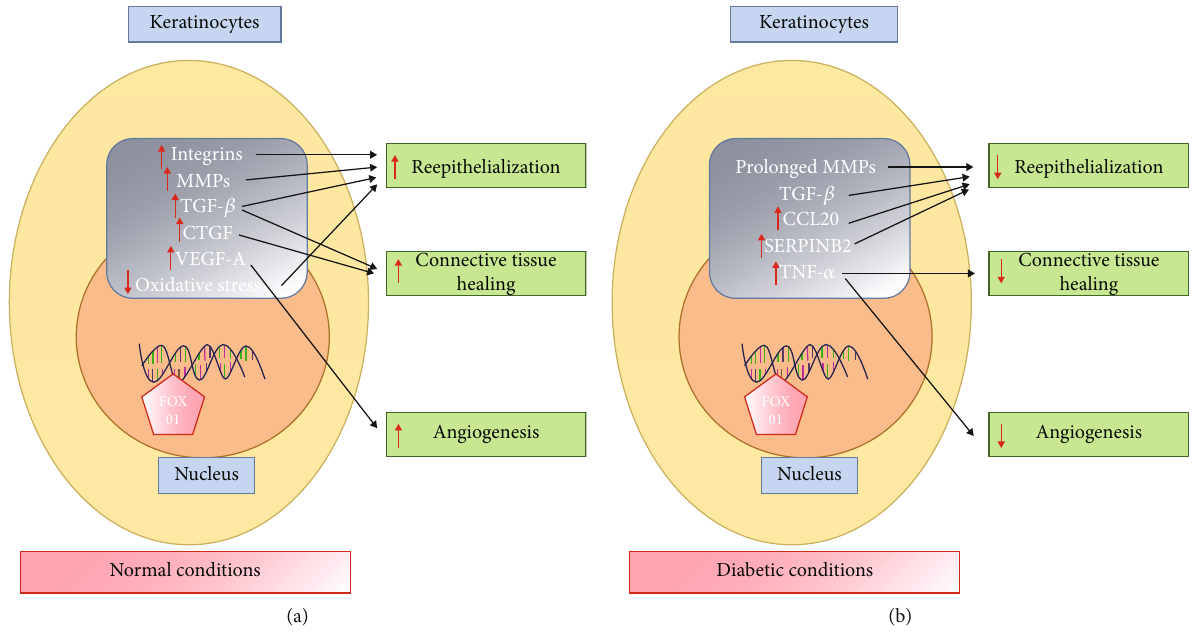
Figure 1: (a) Under normal conditions, FOXO1 promotes reepithelialization through upregulating the expression of integrins, MMPs, TGF- β , and antioxidants. FOXO1 promotes connective tissue healing through induction of the TGF- β and CTGF expression and stimulates angiogenesis via upregulating VEGF-A. (b) In diabetic conditions, FOXO1 exhibits reduced binding to the TGF- β 1 promoter to diminish the TGF- β 1 expression. However, its interaction with a number of factors that inhibit healing when expressed at high levels is increased including MMP-9, CCL20, IL-36 γ , and SERPINB2 which hamper reepithelialization. FOXO1 is induced by high levels of glucose, advanced glycation end products, and TNF that are elevated in diabetic